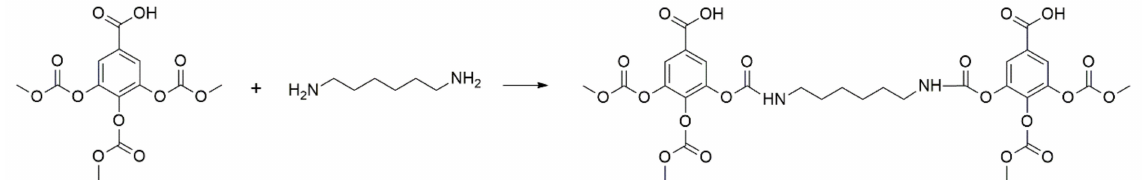
Figure 8. Scheme representation of the tannin-based non-isocyanate polyurethanes (NIPUs) preparation reaction obtained by reaction of hydroxyl groups of tannins with dimethyl carbonate and by hexamethylene diamine